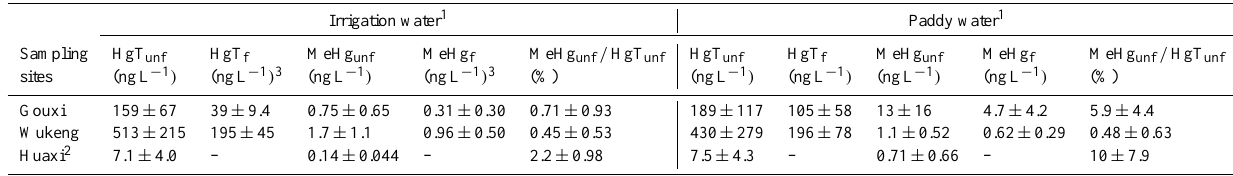
Table 3. Hg irrigation water and paddy water at artisanal Hg mining site (Gouxi), abandoned Hg mining site (Wukeng), and regional background of Huaxi (mean ±